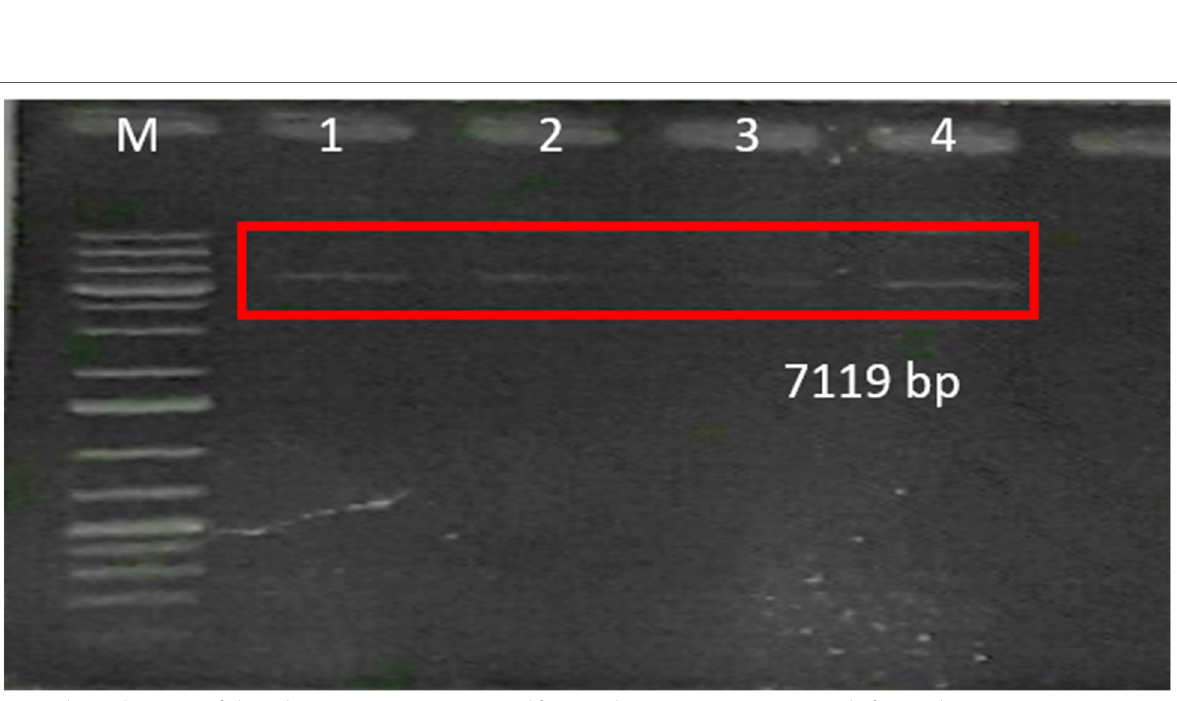
to identify the presence of ligated inserts and deter- mine the direction in the TA cloning-pETSUMO vec- tor. The plasmids of the confirmed colony were digested using XbaI (NEB), which only cut the plasmid in one site and generated linearized DNA. From the results